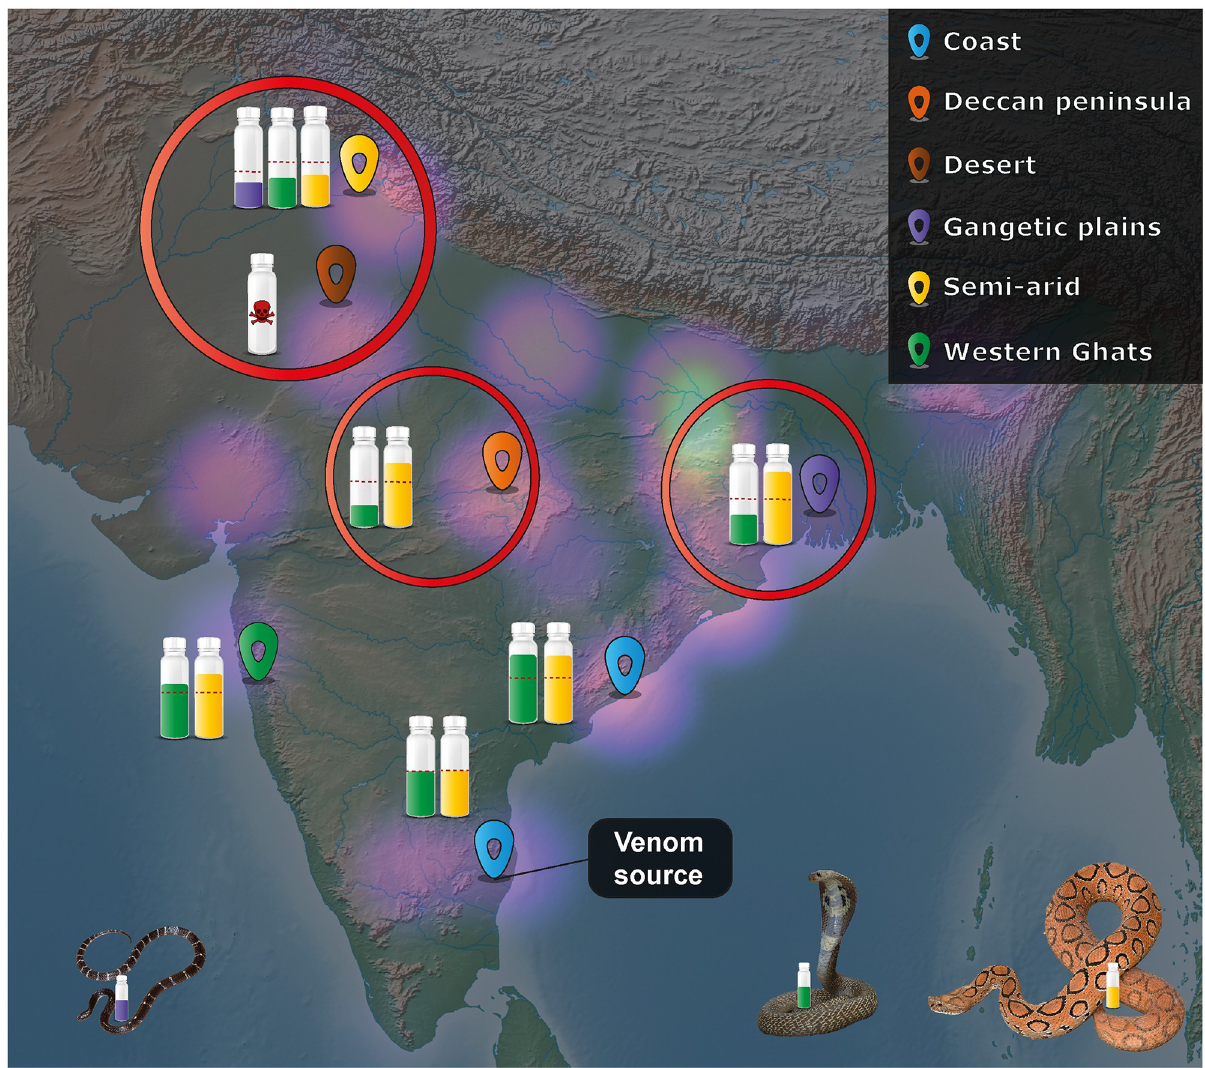
Fig 7. The preclinical inefficacy of Indian antivenom therapy in snakebite hotspots. This figure depicts the alarming preclinical ineffectiveness of commercial antivenoms in the major snakebite hotspots of India (highlighted in red circles). The relative differences in neutralisation potencies of antivenoms against the geographically distinct populations of N . naja (green vials) [71], D . russelii (yellow vials) and B . caeruleus (purple vial) [20] are shown in comparison to the venom source (for antivenom production) population in southern India. The red dotted lines on vials represent the marketed neutralising potency of the commercial products. Sampling locations have been indicated with uniquely coloured markers (top right box) on the biogeographical map of India that was prepared with QGIS 3.8.2 [35]. The intensity of purple clouds on the map is indicative of the estimated standardised snakebite death rates per million reported by Suraweera et al . 2020 [2], with the brighter regions representing the major hotspots.